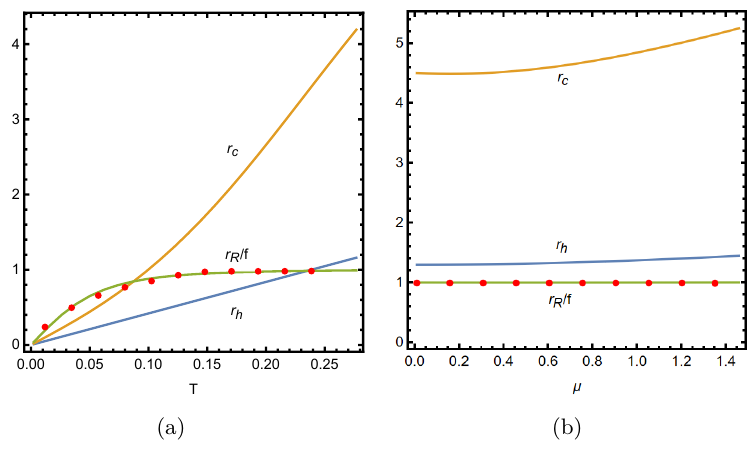
Figure 11 . The circular orbit r c , event horizon r h , and ring radius r R in the unit of f as functions of temperature T at the fixed chemical potential µ = 2 in (a) and as functions of chemical potential µ at the fixed temperature T = 1 /π in (b). The solid curves represent the results obtained by the geometric optics, while the wave optics results are indicated by the discrete red